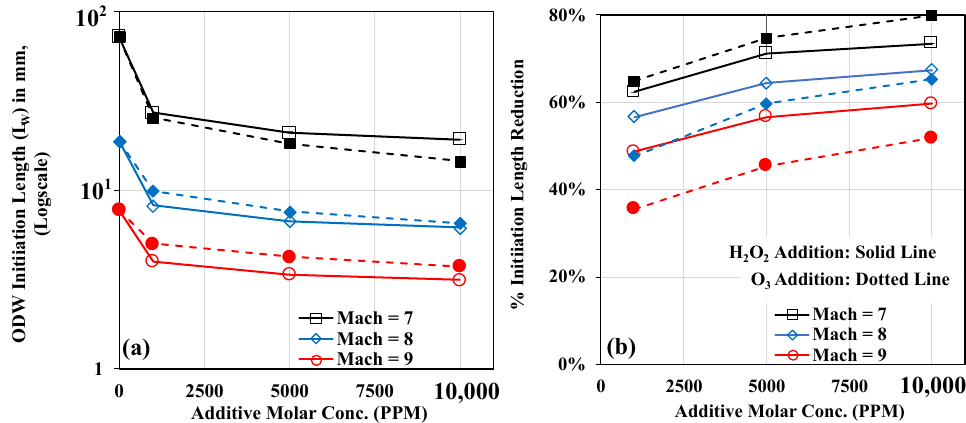
Figure 9. Initiation length ( a ) variation and, ( b ) percentage reduction with additives at H 2 –Air ( φ = 1) premixed